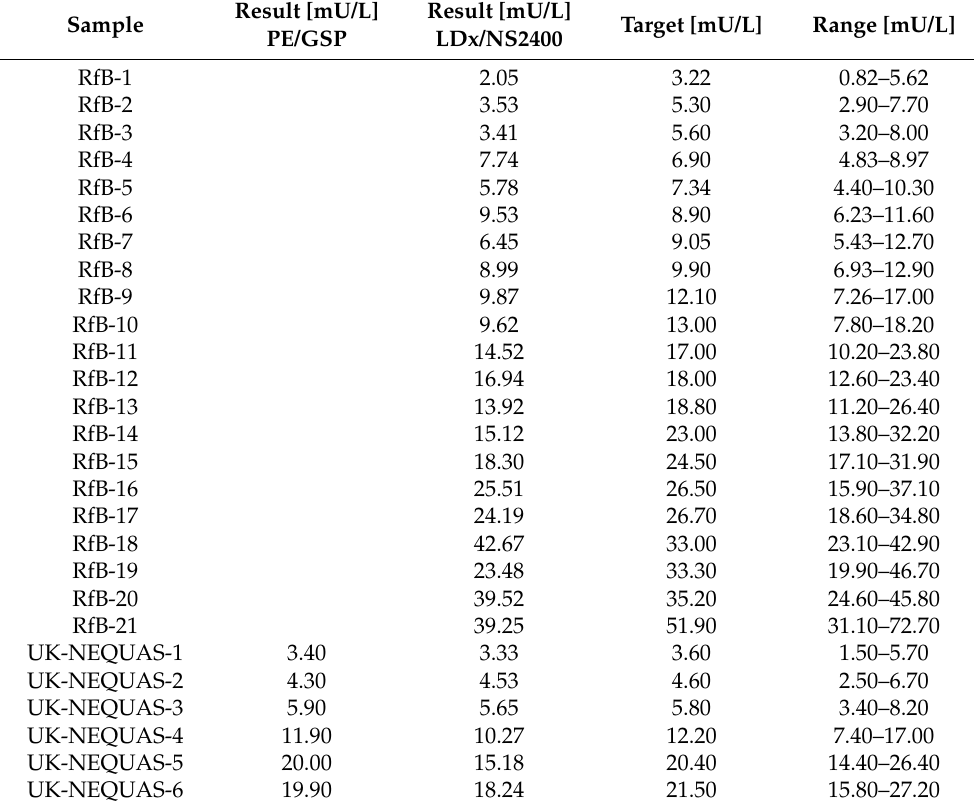
Table 3. Results of EQA samples from RfB, UKNEQUAS, and CDC QC samples on the LDx/NS2400 platform; n = 36, and EQA samples from UKNEQUAS on the PE/GSP platform; n =